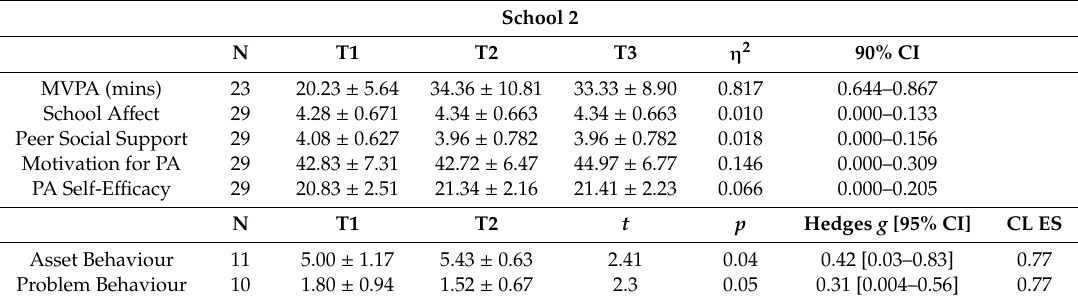
Table 5. School 2—mean scores and change over time for outcome